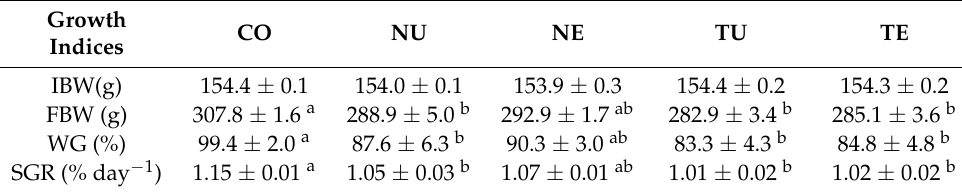
Table 2. Initial, final weight and specific growth rate of Atlantic salmon fed one of the five experi- mental diets for 9